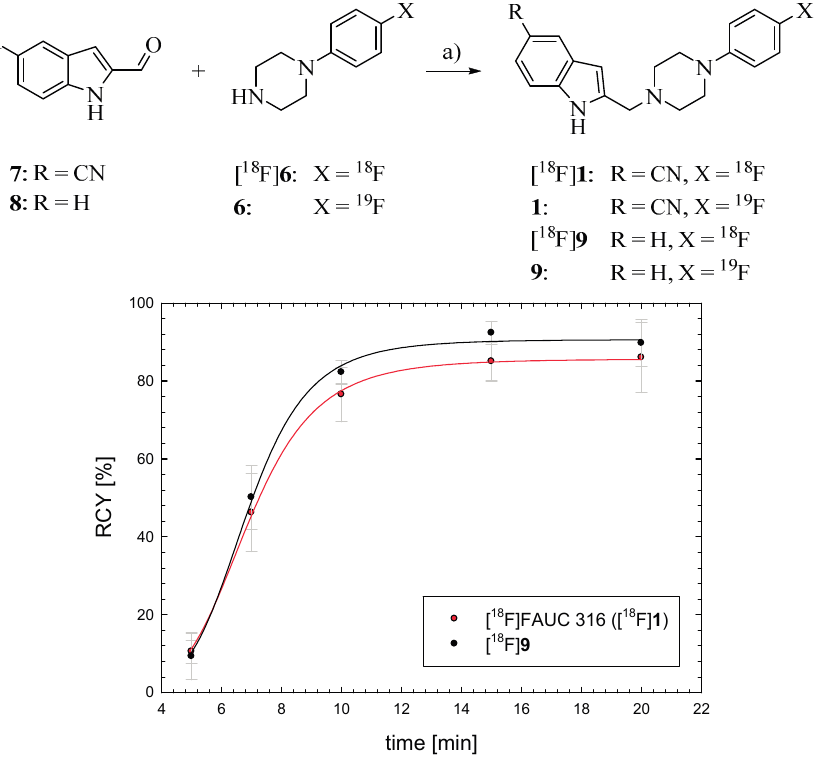
Figure 3. Time dependence of the reductive amination of the indole-2-carbaldehydes 7 and 8 with 1-(4-fluorophenyl)piperazine yielding [ 18 F]FAUC 316 ([ 18 F] 1 ) and the corresponding ligand [ 18 F] 9 without a nitrile substituent for comparison. Reaction conditions: NaBH 3 CN, AcOH, DMSO, 110